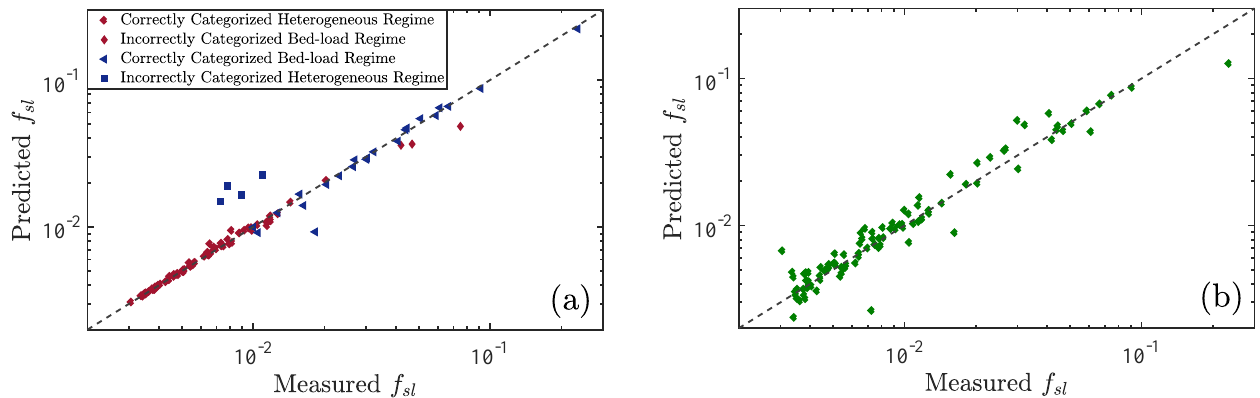
Figure 13. The measured and predicted slurry friction factor parity plot for ( a ) integrated method and ( b ) batch-trained